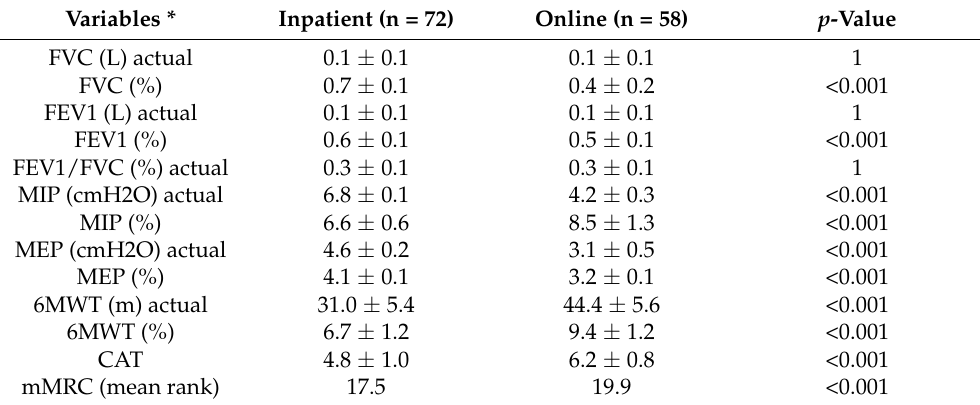
Table 5. Comparison of mean differences in rehabilitation results between inpatients and online